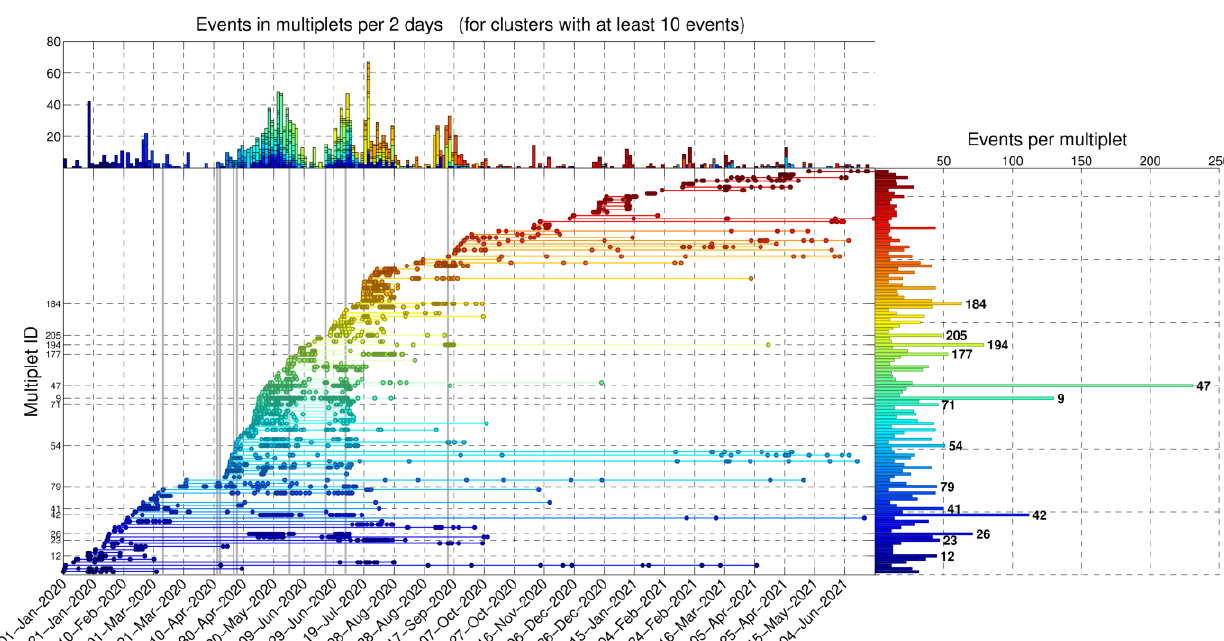
Figure 10. ( Bottom Left ) Multiplet history diagram for events of CAT3 (templates and multi-channel detections) with M ≥ 0.5, clustered with farthest-neighbor linkage (at a similarity threshold of 0.5), after removal of multiplets with less than 10 events. Each row is a different multiplet, sorted from bottom to top by ascending order of the origin time of the first event in each cluster. ( Top ) Stacked histogram of the number of events belonging to the selected multiplets every two days, with the horizontal (temporal) axis the same as that of the bottom-left panel. ( Right ) Number of selected events in each multiplet of the corresponding row of the ( Bottom Left ) panel. The occurrence of events with M ≥ 3.0 is marked with vertical gray lines in the ( Bottom Left ) panel. The multiplet ID of the largest clusters (containing over 45 events with M ≥ 0.5) is marked in the bottom panels.